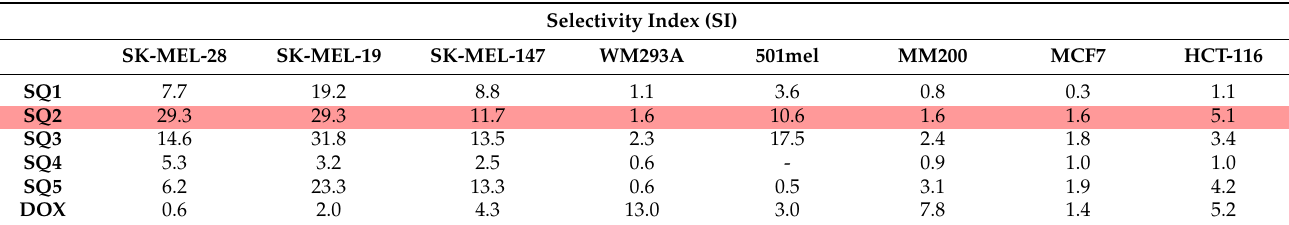
Table 2. Selectivity Index (SI) of SQ1 , the synthetic analogues ( SQ2–SQ5 ) and doxorubicin (DOX) for cancer (SK-MEL-19, SK-MEL-28, SK-MEL-147, WM293A, 501mel, MM200, MCF7, and HCT-116) versus normal primary fibroblast cells (FDH). Data was reported as the ratio of the 72-h IC 50 value as compared to FDH cells. Highlighted in red, SQ2 presented higher SI values than SQ1